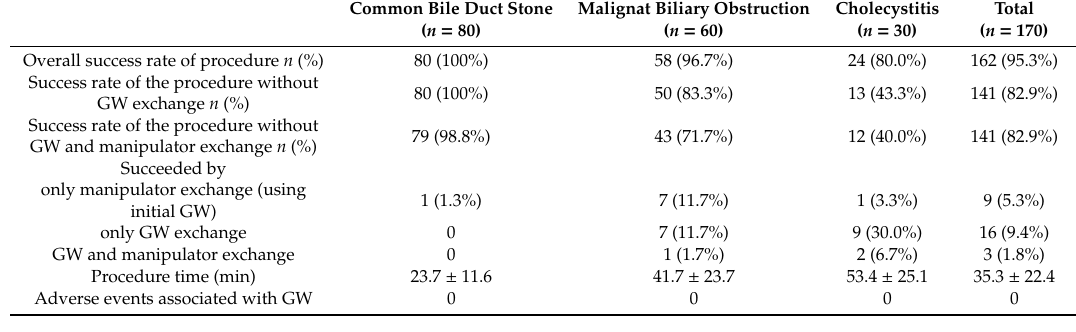
Table 2. Details of procedure outcomes. Common Bile Duct Stone ( n = 80)